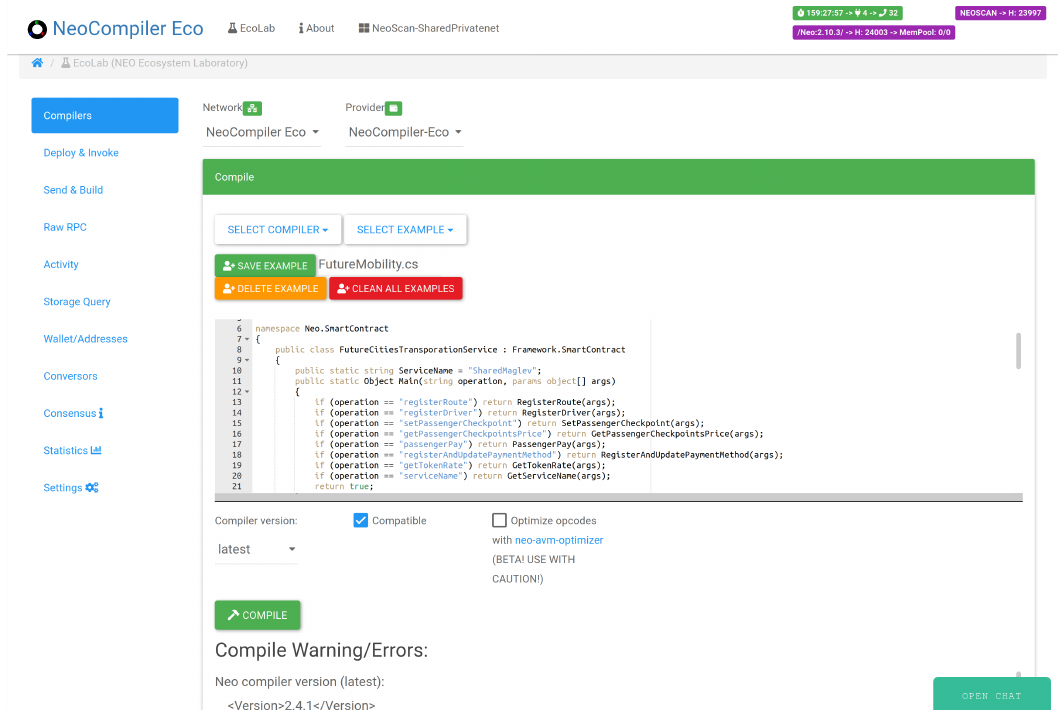
Figure 4. A draft of some functions that could be called for registering operations on the NEO Blockchain, designed with the assistance of